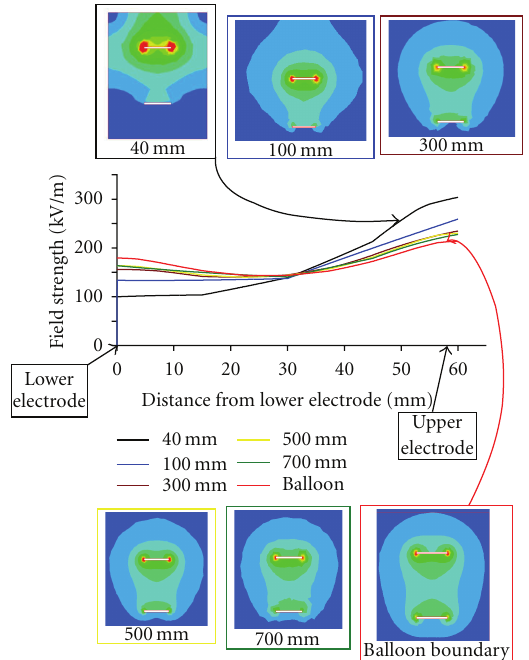
Figure 1: Graph to show the a ff ect of altering the distance between the Faraday cage and the electrodes.